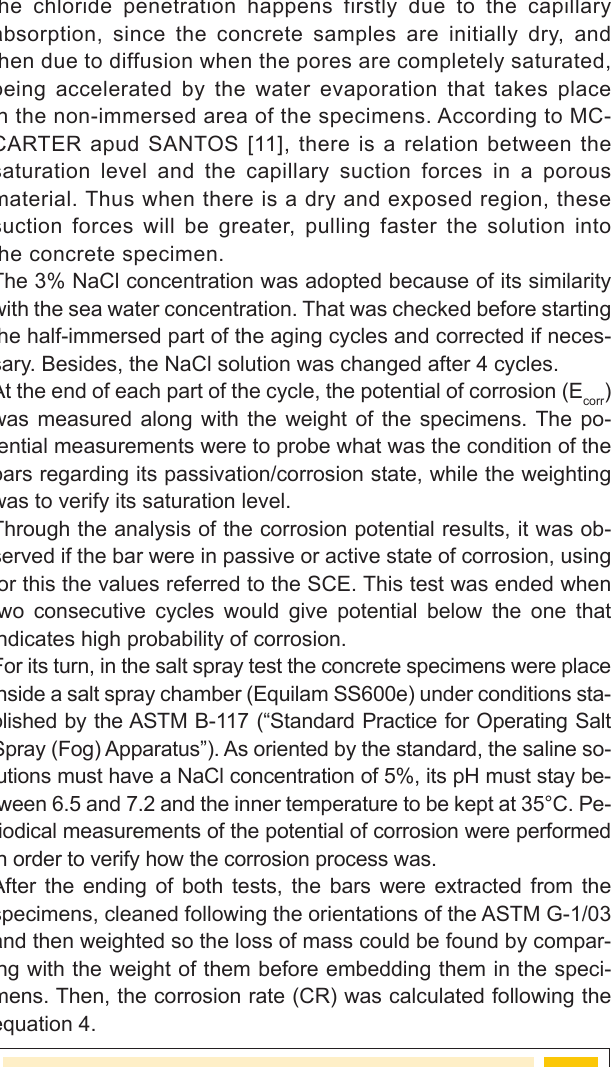
Figure 4 – Measurement of the potential of corrosion being performed